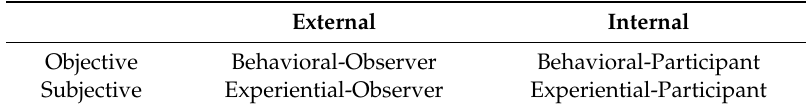
Table 1. Research approaches for defining and measuring leisure [16] (p. 58). (adapted from: Kleiber, Walker and Mannell